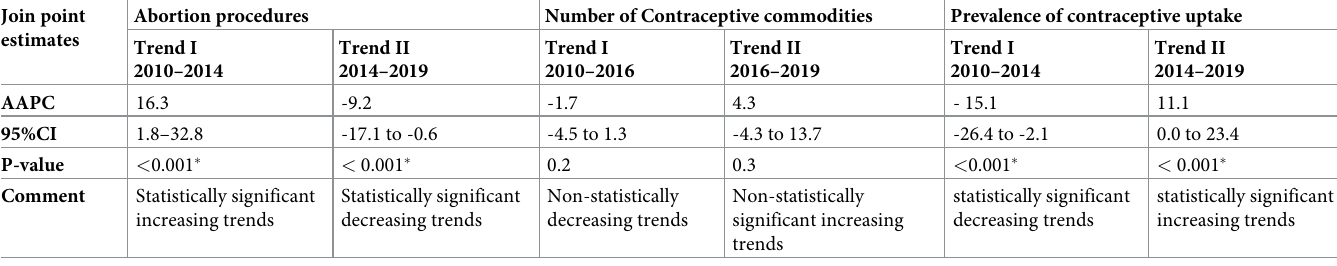
Table 6. Join point regression estimates of the trends in overall abortion and contraceptive uptake